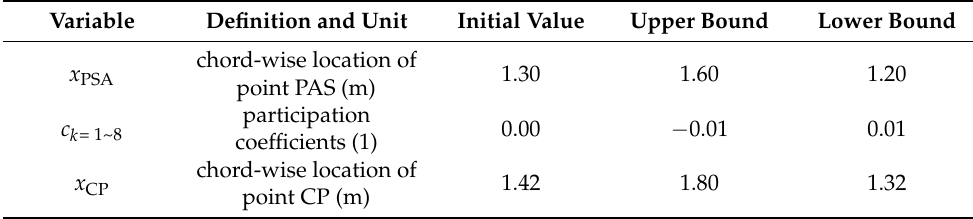
Table 3. Design variables of the sectional airfoil under the DEP installation constraints.